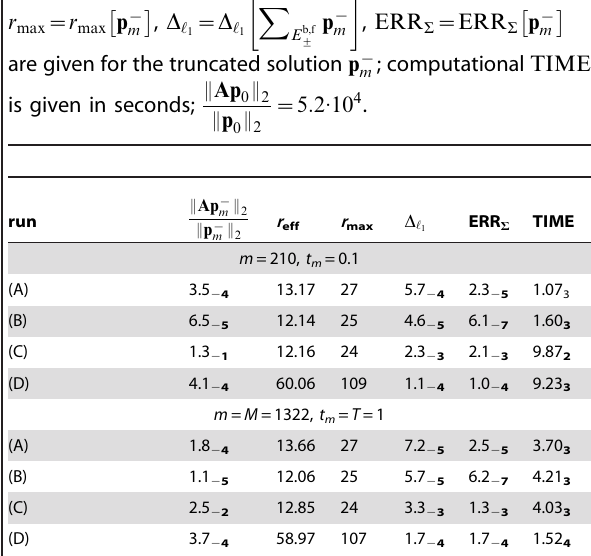
(cid:12) (cid:13) m